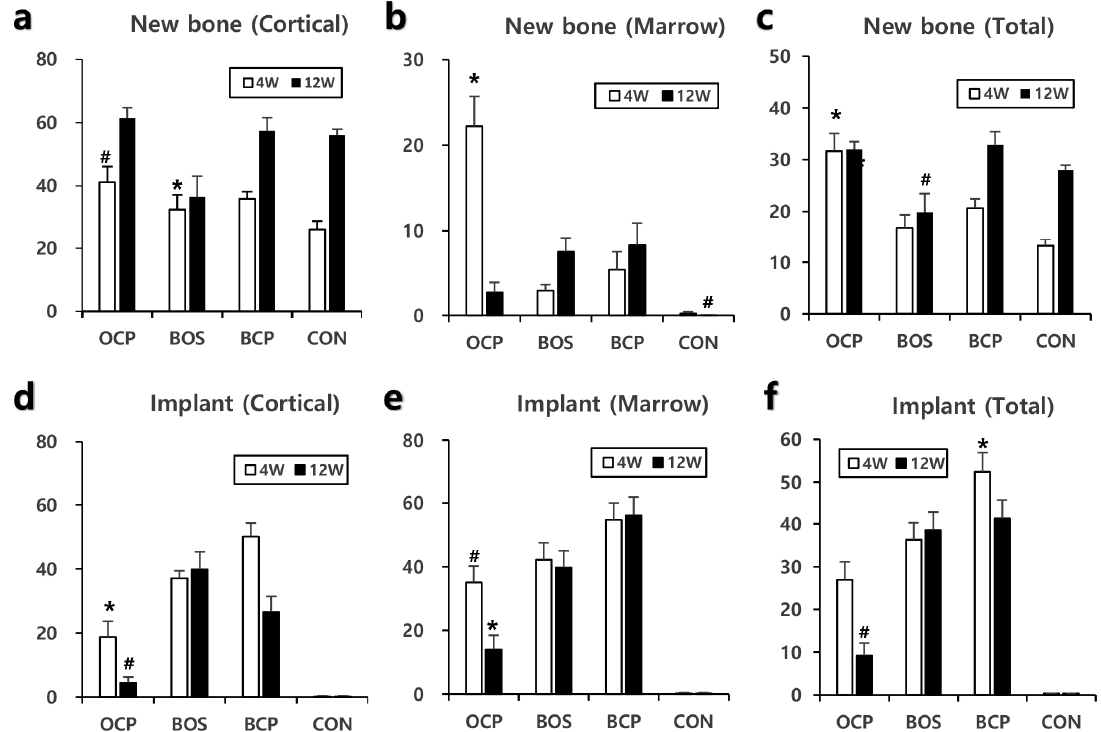
Figure 4. Percentages of new bone and implant remnant to the total corresponding area in cortical bone and marrow areas. The results are presented as the mean ± SE values ( n = 9). * p < 0.05 between this group and other groups at same week. #: p < 0.05 between OCP and CON in ( a ), between CON and BHA or BCP in ( b ), between BHS and OCP or BCP in ( c ), between OCP and BHA or BCP in ( d ), between OCP and BCP or CON in ( e ), between OCP and BHA or BCP in ( f ), all in the same week.